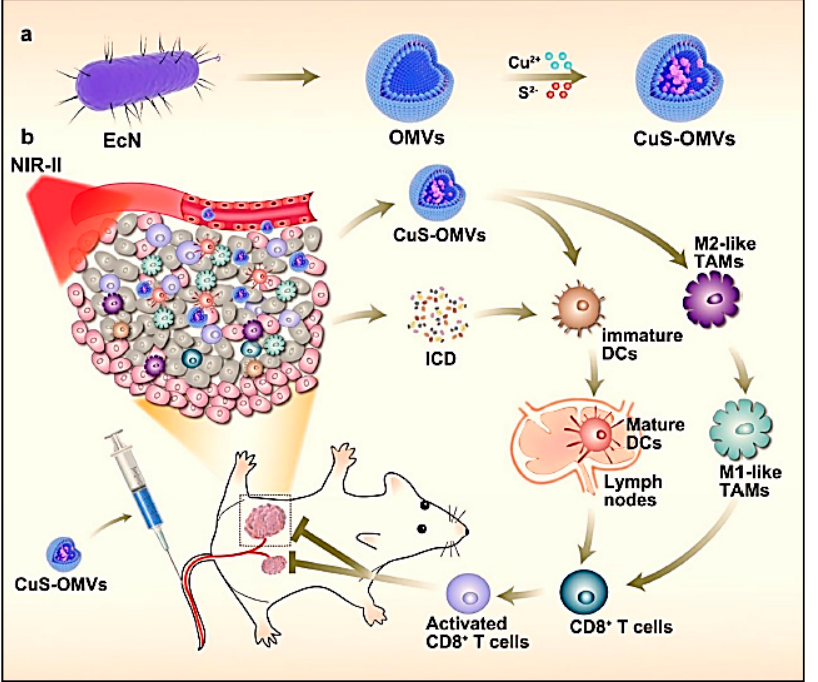
Figure 13. CuS-OMVs for combinational cancer therapy involving PTT and immunotherapy. ( a ) Schematic representation of the preparation of CuS-OMVs. ( b ) Schematic representation of PTT and antitumour immunity generated by CuS-OMVs following NIR–II light exposure. CuS-OMVs target tumours effectively and cause cytotoxicity in tumour cells due to a combination of ICD, DC maturation and CD8 + T-cell activation in response to NIR-II light exposure. CuS-OMVs act as immune adjuvants that support DC maturation and repolarize TAMs from M2 to M1 phenotype to inhibit tumour growth and metastasis [146]. Reproduced with permissions from Jiaqi Qin et al., Nano Today , Elsevier, 2022.